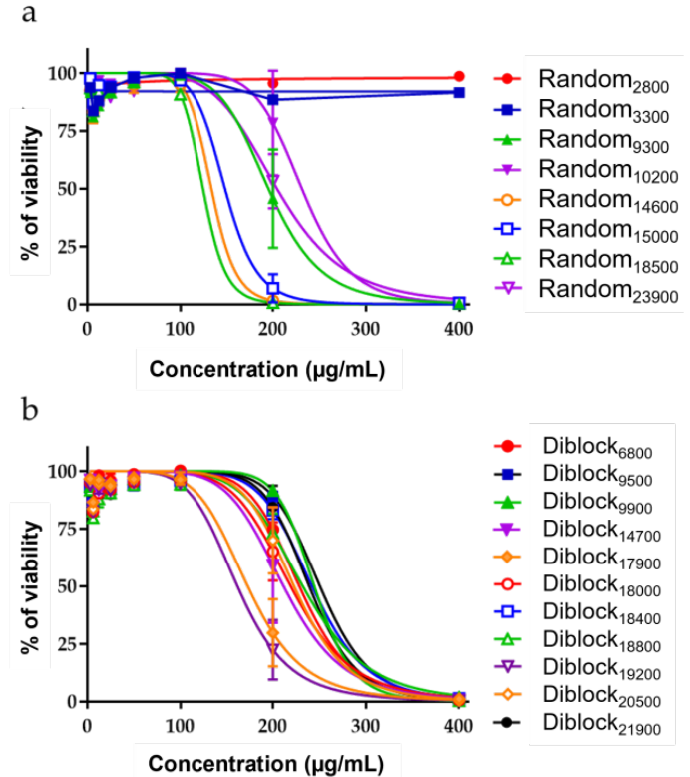
Figure 2. Evaluation of the toxicity of Random and Diblock copolymers. Non tumorigenic human airway epithelial cells (BEAS-2B) were exposed for 48 h to increasing concentrations of Random ( a ) or Diblock ( b ) copolymers. At the end of the incubation, the cell viability (expressed as % of viability of control cells) was measured using the resazurin assay. Data were analyzed using GraphPad Prism (n = 3). Table 3. Evaluation of the innocuity of Random and Diblock copolymers. IC 50 values of Random and Diblock copolymers (expressed in µg/mL) on BEAS-2B viability were calculated using data from Figure 2a. Therapeutic Index (TI) was calculated by dividing the IC 50 of the copolymer by their MIC value for each bacterial strain.